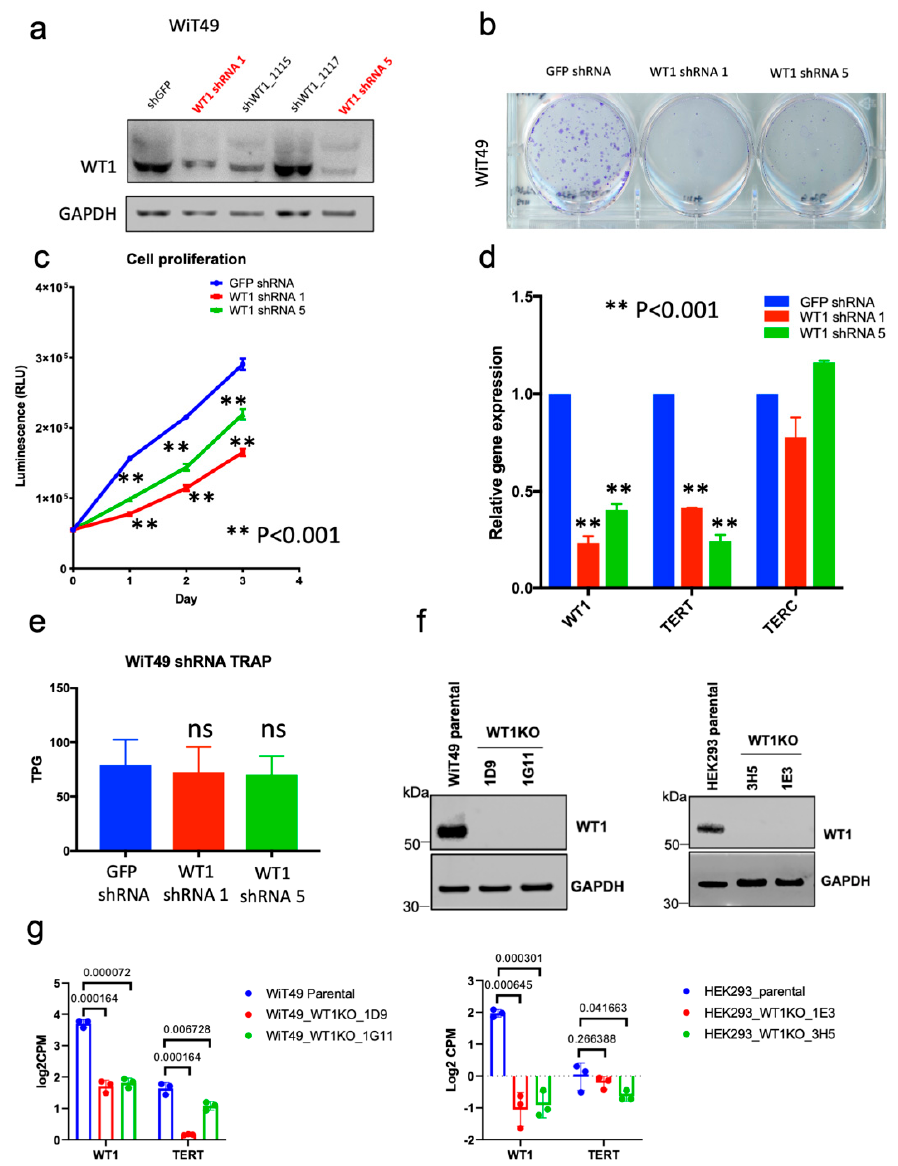
Figure 4. Functional association of WT1 and TERT in Wilms tumor cells in vitro. ( a ) shRNAs were knock down of WT1 in anaplastic WiT49 cells. ShRNAs 1114 (shRNA 1) and 0596 (shRNA 5) were had adequate knockdown by western blot when compared to GFP non-targeting control. ShRNA knockdown of WT1 was associated with ( b ) decreased colonies in a crystal violet assay and ( c ) cell proliferation at 1, 2, and 3 days (two-tailed t -test p < 0.001 all time points). ( d ) shRNA knockdown of WT1 caused significant decrease in TERT expression ( p < 0.001), but a nonsignificant reduction in ( e ) telomerase activity (TRAP assay). ( f ) Abrogation of WT1 protein detection in WiT49 and HEK293 WT1 knockout clones. ( g ) CRISPR-Cas9-mediated knockout of WT1 in WiT49 cells (WiT49-1D9 and WiT49-1G11 clones) and HEK293 cells (HEK293-1E3 and HEK293-3H5 clones) was associated with decreased WT1 and TERT ( p values shown for each clone).